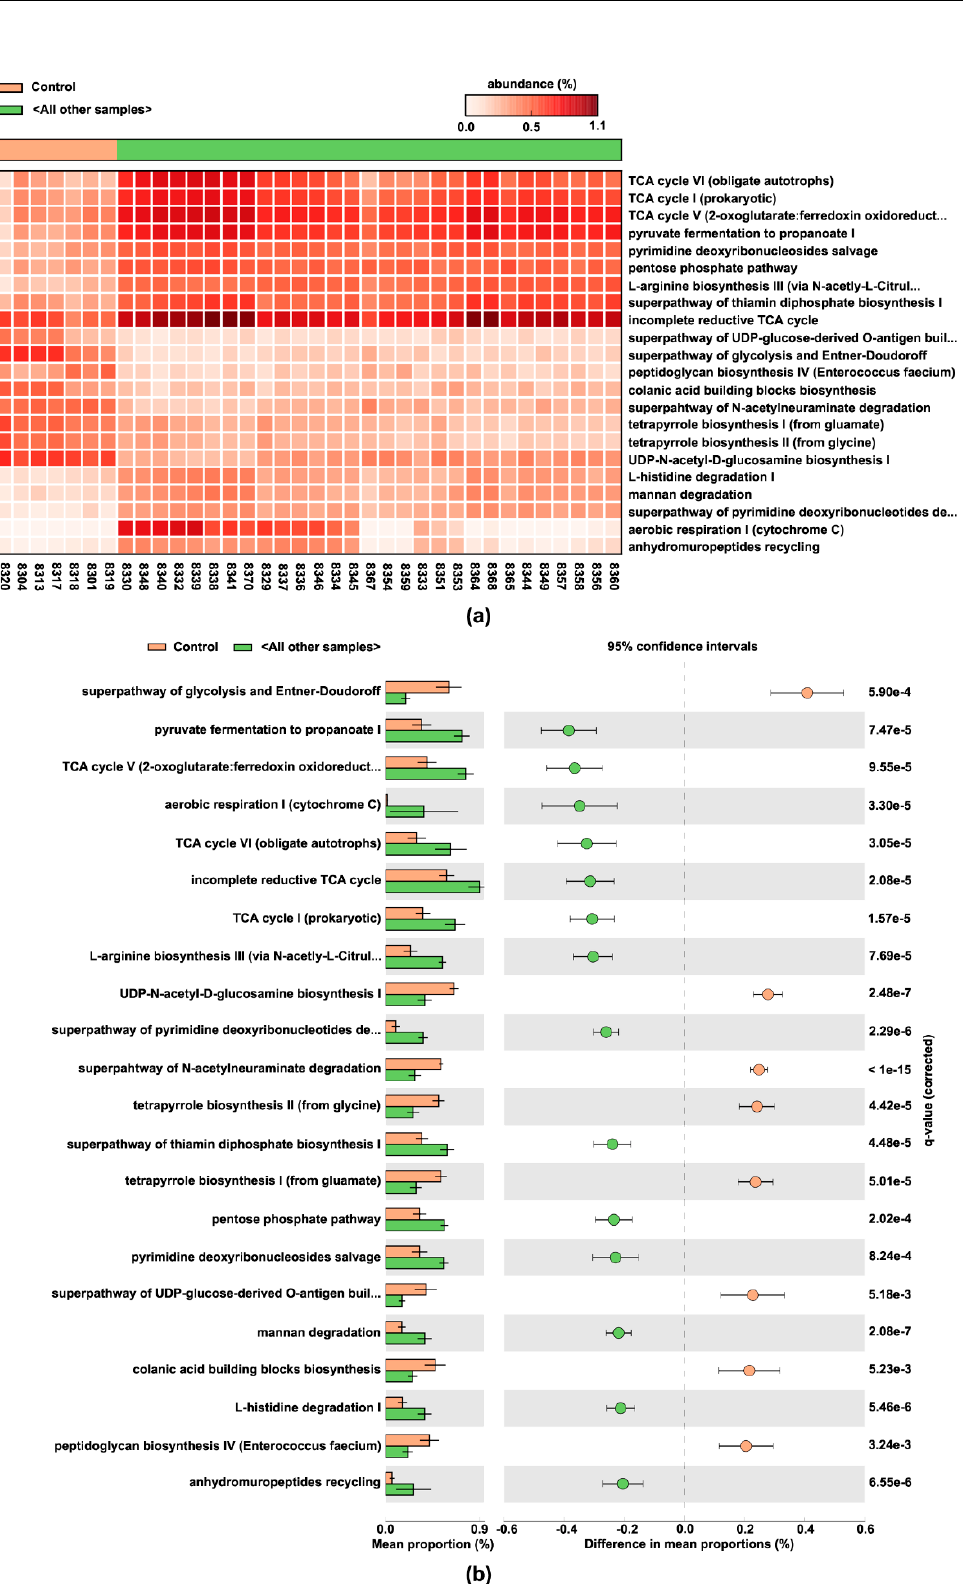
Figure 8. PICRUSt2 results indicating differential pathways between the pulse-free and pulse-based diet groups. Twenty-two out of 179 significant pathways with effect size over 20% for the difference between proportions and over 1.5-fold for the ratio of proportions are presented here. Pulse-free diet (“Control”) is indicated in beige, while pulse-based diet samples (“All other samples”)—in green: ( a ) Heatmap plot indicating the abundance of pathways assigned to each sample. ( b ) Extended error bar plot indicating the mean proportion of pathways assigned to each group, difference between them, and corrected p -value ( q -value) of each.